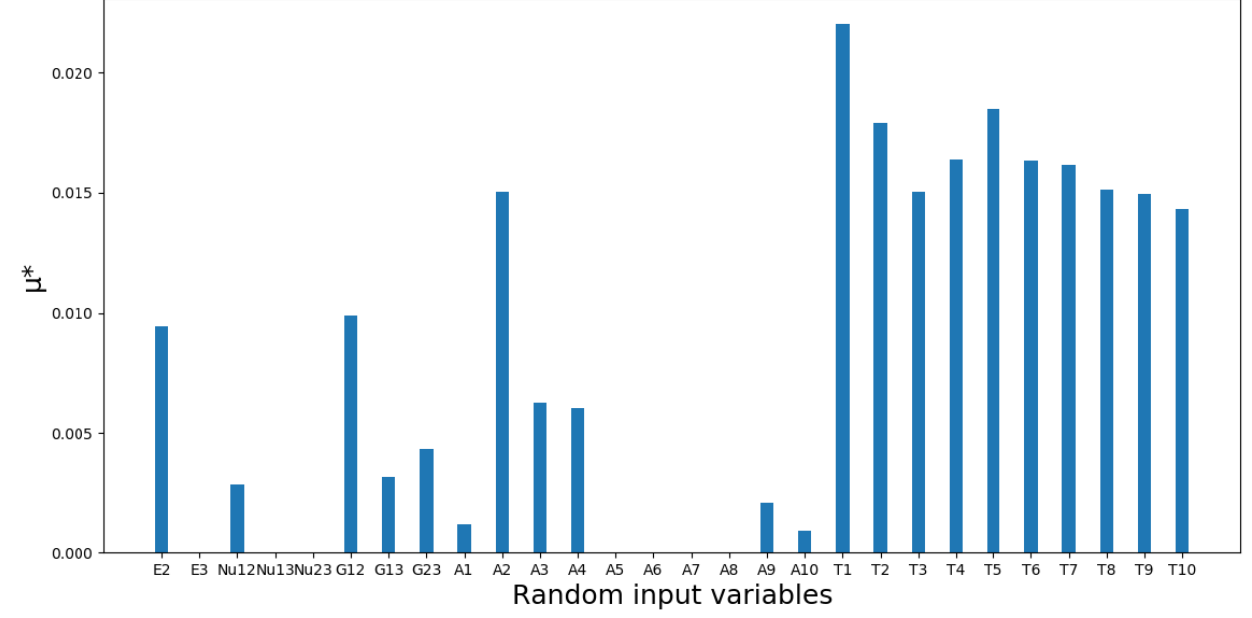
Figure 10. Values of μ* for all random variables except E1 4.